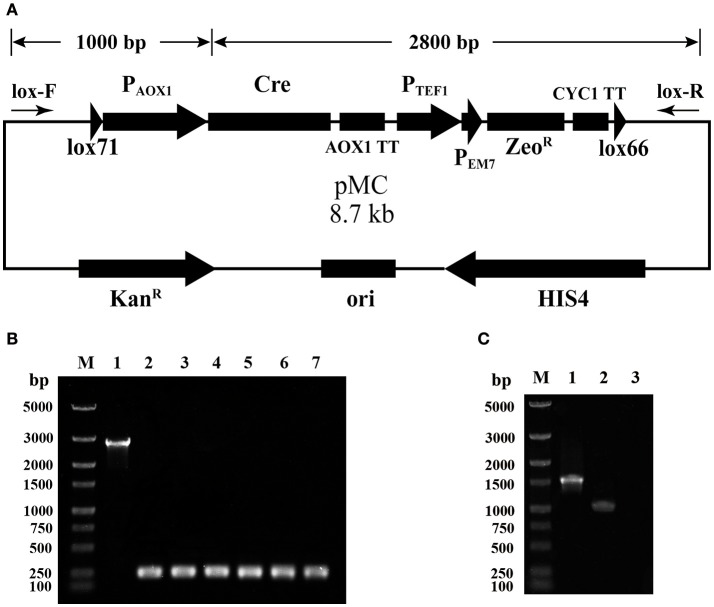
Identification of the leakage expression of Cre recombinase. (A) The map of plasmid pMC. The primer pairs lox-F/R are indicated by arrows, and the calculated molecular weight of the two detected fragments is shown on top. (B) Single-colony PCR analysis of E. coli (pMC). Line M, DNA marker; Line 1, the detected fragment of Cre-AOX1TT-PTEF1-PEM7-ZeoR-CYC1TT-lox66; Line 2–7, the detected fragment of lox71-PAOX1-Cre-AOX1TT-PTEF1-PEM7-ZeoR-CYC1TT-lox66. (C) RT-PCR analysis of E. coli (pMC). Line M, DNA marker; Line 1, positive control of 16s rRNA gene; Line 2, cre gene; Line 3, negative control.